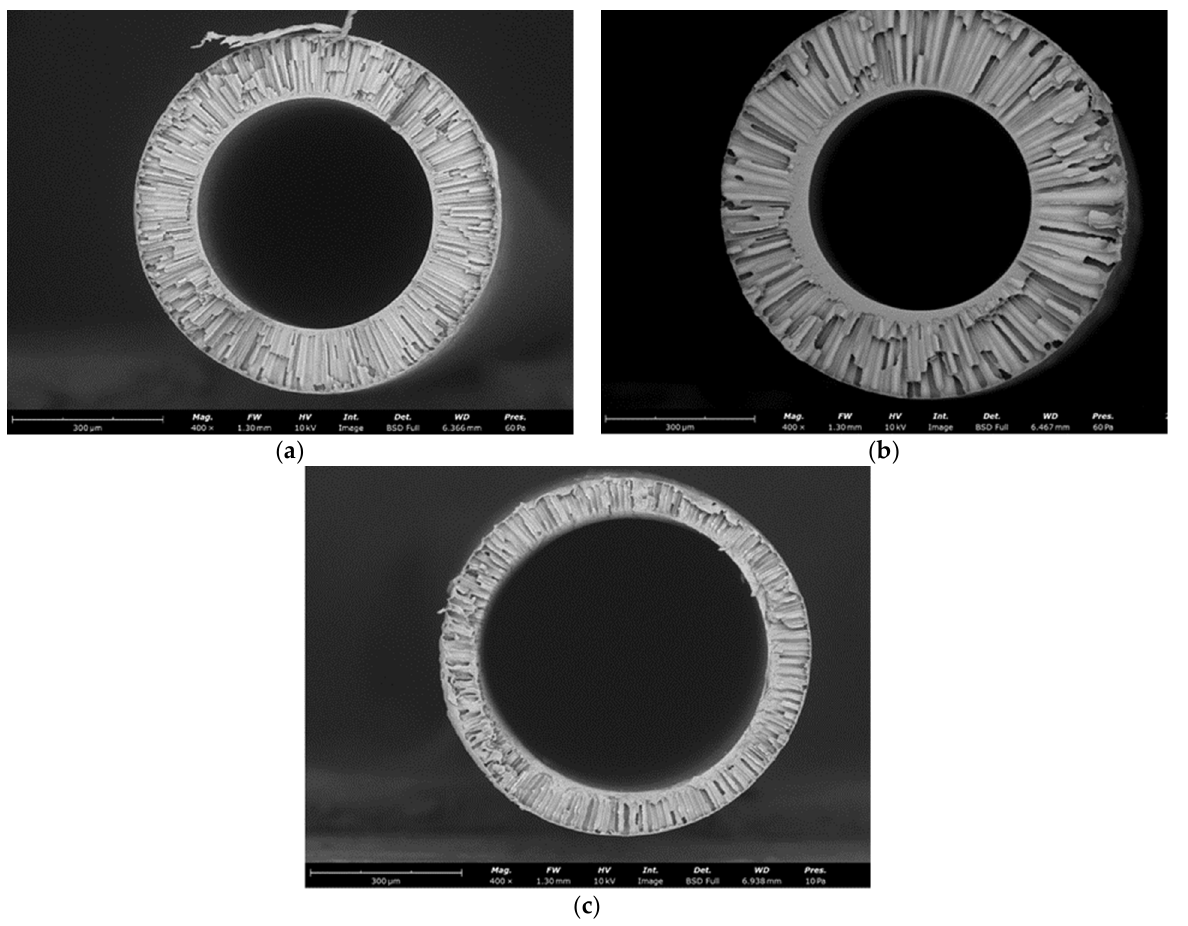
Figure 7. SEM micrographs of the cross-section of hollow fiber membranes obtained from synthesized ( a ) PSF-1, ( b ) PSF-7 and ( c ) PSF-8.